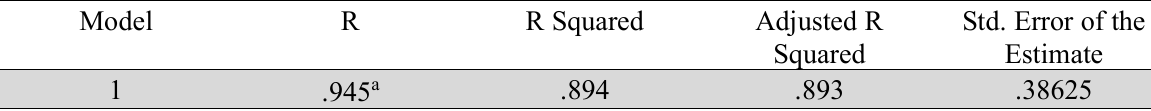
Model 1 Summary